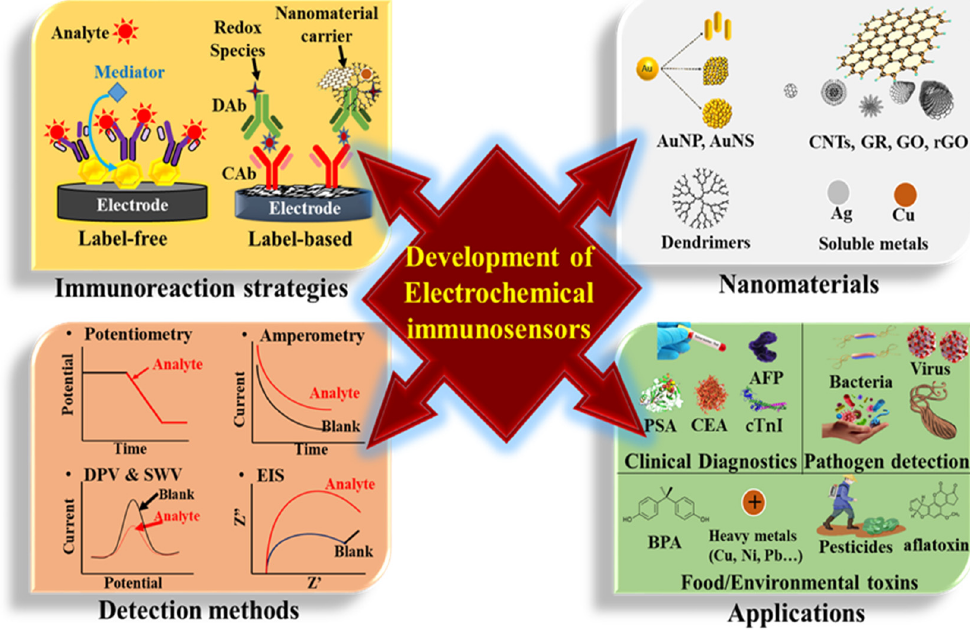
Figure 1. The concerned issues in nanomaterial-based electrochemical